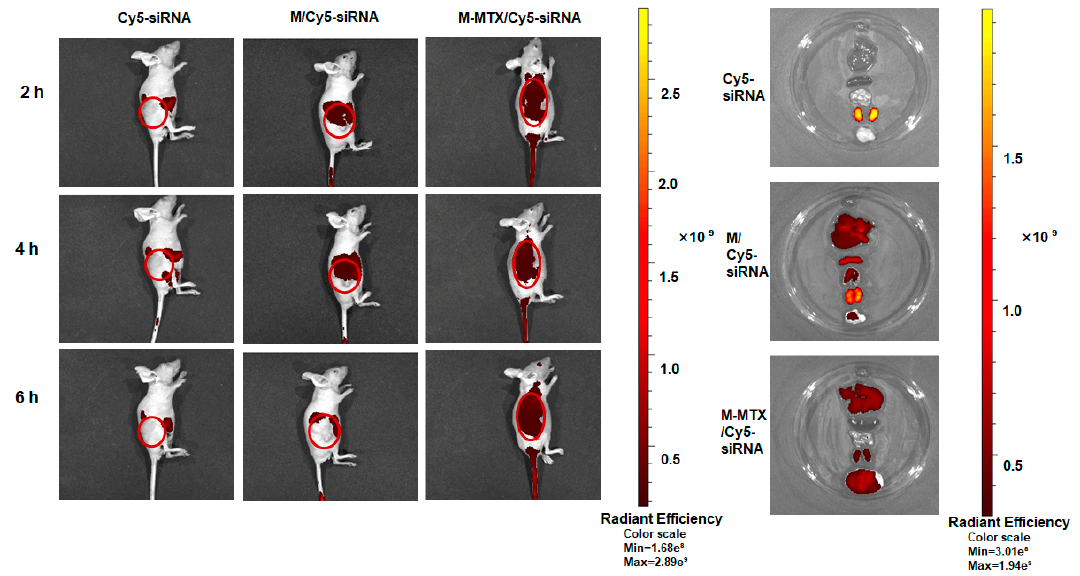
Figure 5. The biodistribution of M-MTX/Cy5-siRNA in tumor-bearing mice. ( Left ) The real-time fluorescence imaging of tumor-bearing mice injected with naked Cy5-siRNA, M/Cy5-siRNA, and M-MTX/Cy5-siRNA via tail vein were obtained at the second, fourth, and sixth hours after administration (Cy5-siRNA = 1 nmol). ( Right ) The ex vivo imaging of the tumors and organs excised from tumor-bearing mice at the sixth hour after injection. The images were obtained by IVIS® In Vivo Imaging System with an optimized parameter (excitation, 640 nm; emission, 680 nm).